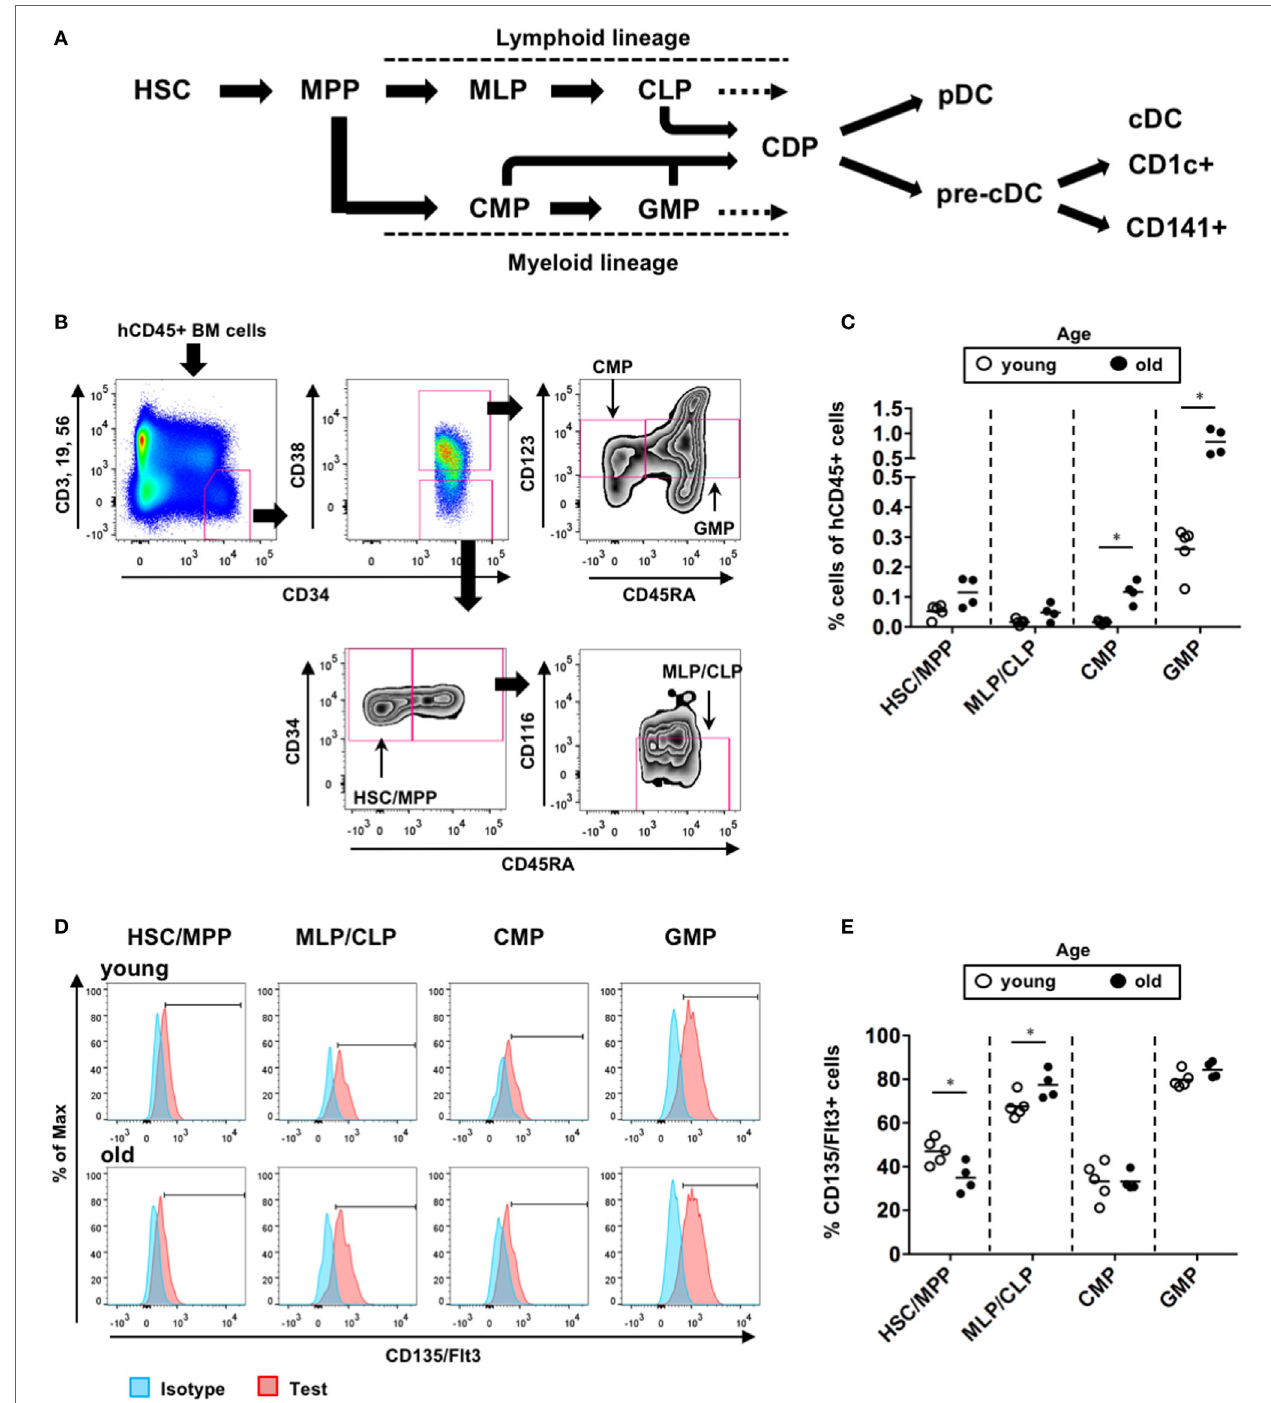
FigUre 6 | Composition of hematopoietic progenitors in hNOJ mice. The young (4-week-old) and old (16-week-old) hNOJ mice were subjected to in vivo transfection (IVT) with the empty vector plasmid. At 10 days post-IVT, bone marrow (BM) cells were analyzed by flow cytometry. (a) Schematic view of human dendritic cell hematopoiesis. (b) Identification of BM hematopoietic progenitors in hNOJ mice: hematopoietic stem cell (HSC)/MPP (CD34 + CD38 − CD45RA − ), MLP/CLP (CD34 + CD38 − CD45RA + CD116 − ), CMP (CD34 + CD38 + CD45RA − CD123 lo ), and GMP (CD34 + CD38 + CD45RA + CD123 lo ). (c) Comparison of the frequency of each hematopoietic progenitor population between the young and old hNOJ mice. Data are the individual values (young: n = 5, old: n = 4). Significant differences (* P < 0.05) were determined by the Mann–Whitney U test. (D) Representative histograms of CD135/Flt3 and isotype staining. (e) Comparison of the frequency of CD135/Flt3 + cells within each hematopoietic progenitor population between the young and old hNOJ mice. Significant differences (* P < 0.05) were determined by an unpaired t